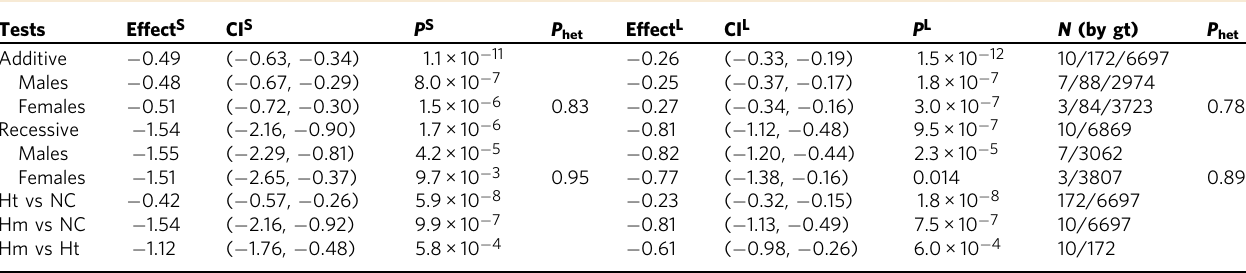
Shown are associations with standardized ( S ) and and log transferred ( L ) SNAP. Effect difference between males and females was tested for statistical heterogeneity with a Q -test ( P het ) 19 (Methods). Effect S in standard deviations (SD), Effect L in log( μ V), 95% con fi dence interval (CI), Additive model (Additive), Recessive model (Recessive), Homozygotes (Hm), Heterozygotes (Ht), Non-carriers (NC). Sample size ( N ) by genotype (gt)